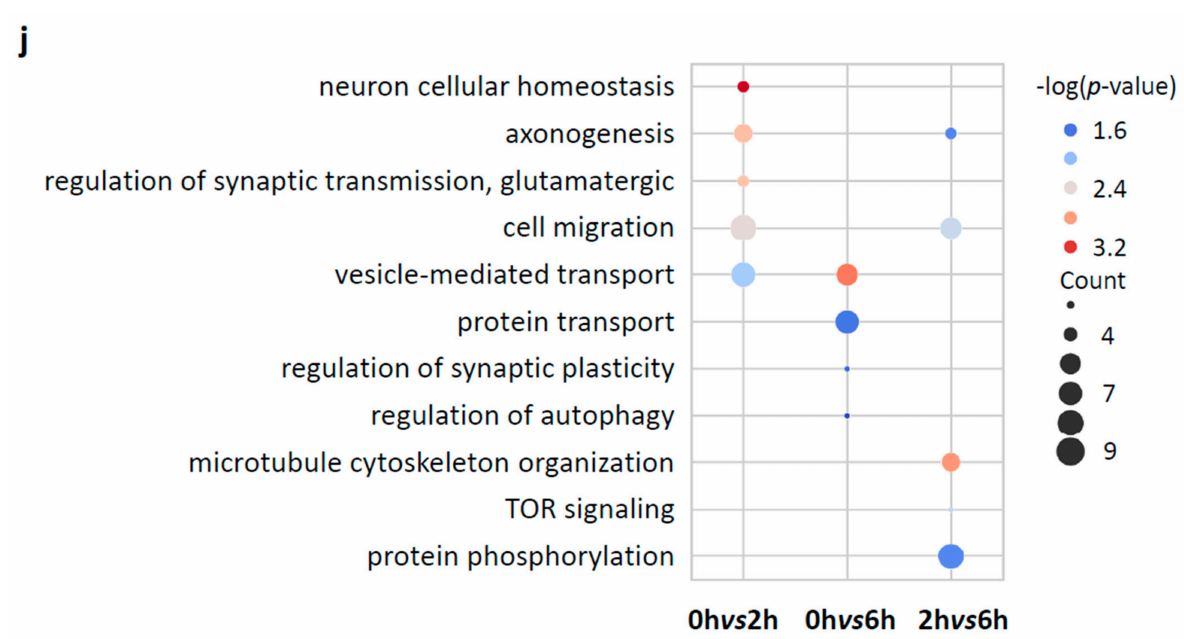
Figure 5. Neuronal depolarization induced m 5 C methylation changes in mouse cortical neurons. ( a – c ) Venn diagram showing the overlap of m 5 C sites between two conditions: 0 h vs. 2 h ( a ), 0 h vs. 6 h ( b ), and 2 h vs. 6 h ( c ). ( d – f ) Box plot showing the methylation level of the union of m 5 C sites between two conditions with 20x coverage in both samples: 0 h vs. 2 h ( d ), 0 h vs. 6 h ( e ), and 2 h vs. 6 h ( f ). A Wilcoxon signed-rank test was performed. ( g – i ) Heatmap showing the methylation profile of hyper- and hypo- DMS sites in the comparison of 0 h vs. 2 h, 0 h vs. 6 h and 2 h vs. 6 h. ( j ) GO annotation of transcripts with DMS